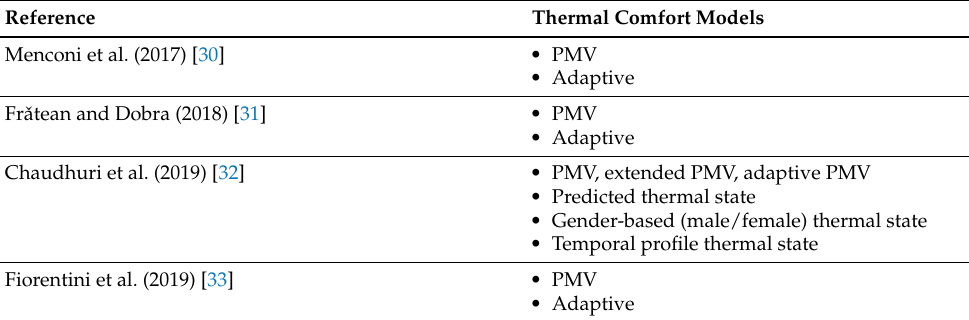
Table 3. Studies using multiple thermal comfort